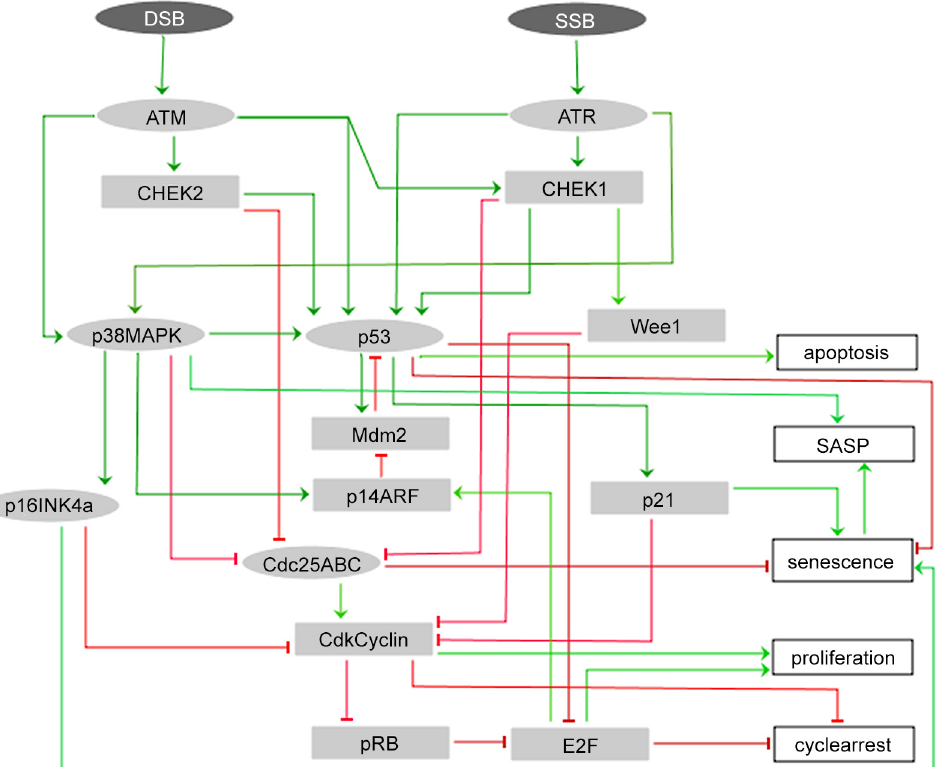
Fig 1. Regulatory network for astrocyte fate decision. Rectangular and elliptic nodes represent Boolean and multi-valued nodes, respectively. The input nodes in dark color at the top of the network denote single (SSB) and double-strand (DSB) DNA breaks, respectively. The output nodes in white color represent the possible cell fate decisions and the internal nodes are the regulators of the